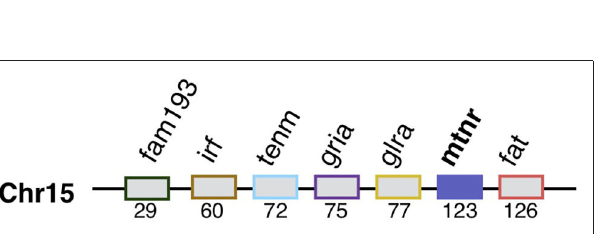
FIGURE 4 | gene locations in the genome assembly are indicated under the gene position. Full names and references of mtnr and neighboring genes are given in Supplementary Table 2 .